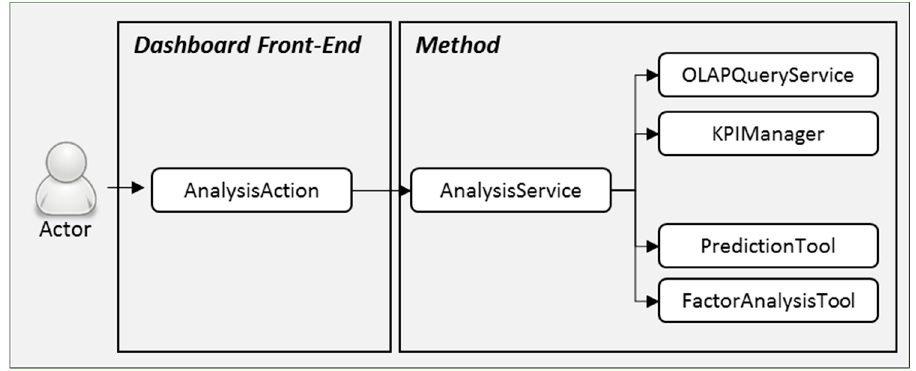
Figure 7. Unified Model Language (UML) of objects implemented in dashboard and their workflow.